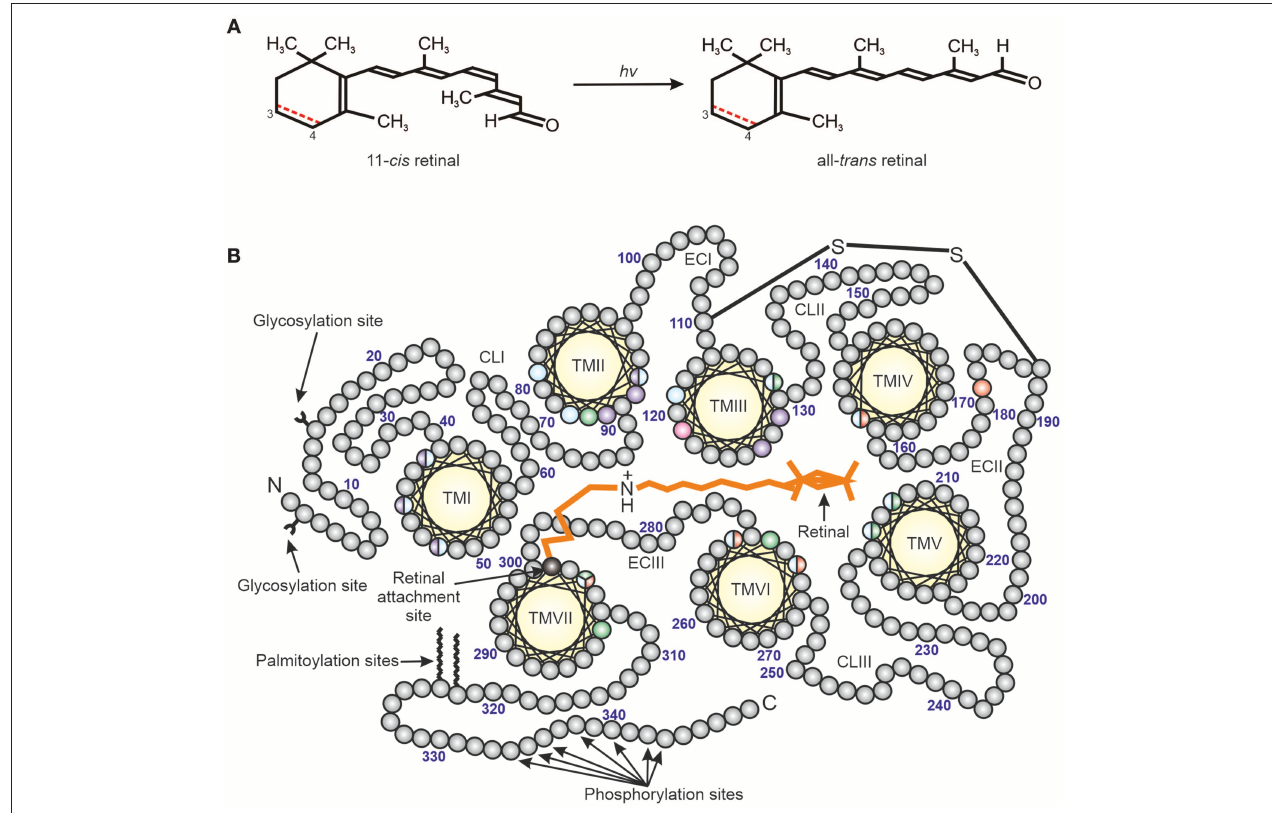
FIGURE 1 | The structure of vertebrate photopigments. (A) The initial step in phototransduction consists of photon ( hv ) absorption by 11- cis retinal, which photoconverts to all- trans retinal. Vertebrate photopigments are broadly divided into rhodopsins that utilize a vitamin A 1 -derived chromophore (black line) or porphyropsins that contain a vitamin A 2 -derived chromophore (3,4-didehydroretinal). In the latter case, the presence of a double (C = C) bond between C 3 and C 4 is shown as a dotted red line. (B) A mid-membrane section of a typical (opsin) photopigment, showing the presence of seven transmembrane domains (yellow), archetypal of the GPCR superfamily, and their arrangement around the retinal chromophore (orange) (modified from Davies et al., 2012). The retinal attachment site (Lys296, black) and counterion (Glu113, pink) to the Schiff base are shown. Opsin residues that cluster either around the Schiff base or ionone ring of the retinal chromophore are colored to highlight the amino acids involved in the spectral tuning of LWS (red), SWS1 (violet), SWS2 (blue) and RH2/RH1 (green) photopigments. Residues important for stabilizing the tertiary structure (e.g., disulphide bridge, amino-terminal (N) glycosylation sites) and the activation/deactivation of photopigments (e.g., carboxyl-terminal (C) phosphorylation sites), as well as membrane anchorage (e.g., palmitoylation sites), are also shown. TM, transmembrane; CL, cytoplasmic loop; EC, extracellular loop. The numbering is based on the bovine rod opsin (RH1)